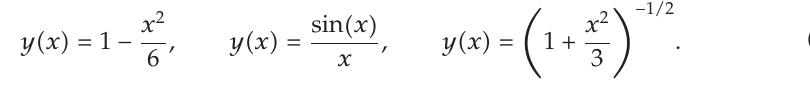
(cid:25) E N,T for Example 4.1.